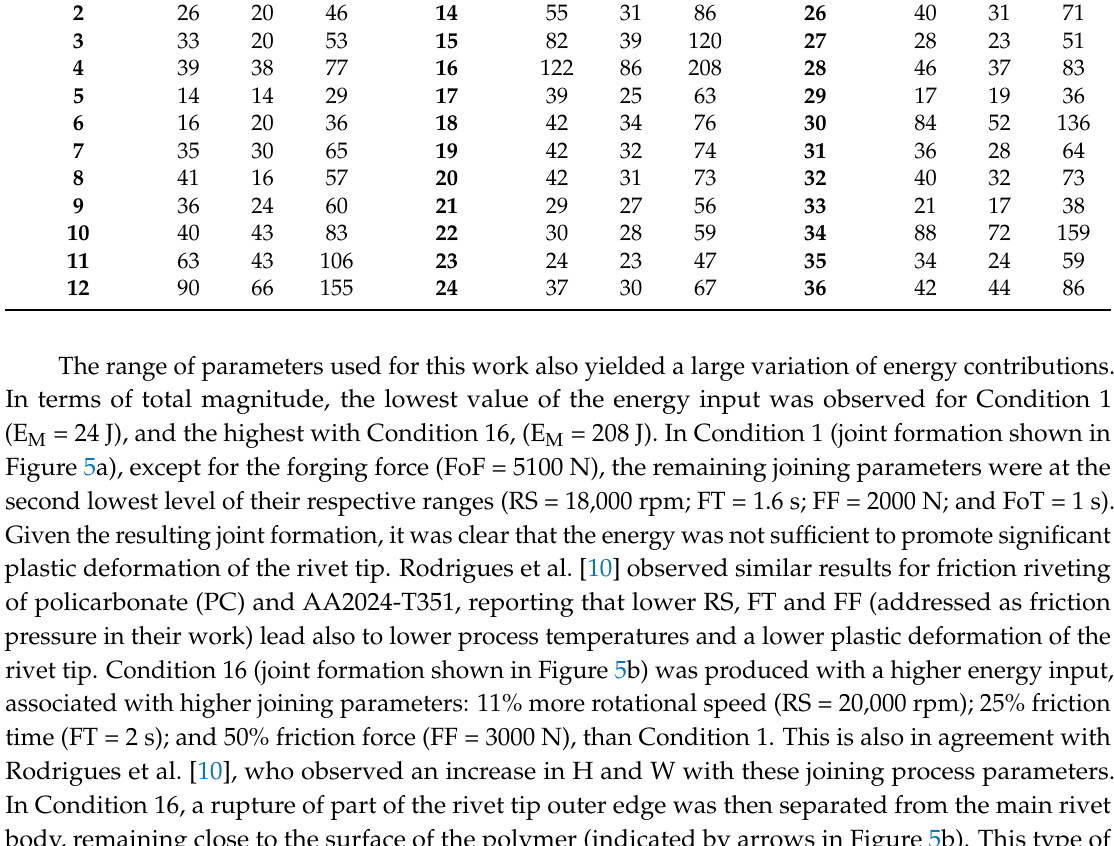
Figure 6. Energy input comparison between Conditions 14 and 36 with total energy input of 86 J. The 15% of the total energy input that in Condition 14 originates from a frictional contribution, in Condition 36 the same 15% generated by deformational energy. This shift in the predominant source of energy promoted a considerable change in the resulting joint formations. Referring to the data presented in the previous section (Table 3), the measurements performed on these joints revealed higher dimensions for the deformed rivet tip of Condition 36. The highest difference in magnitude occurred for the B measurement, encircled in Figure 7, where Condition 36 had an increase of over 30% from the value measured for Condition 14.